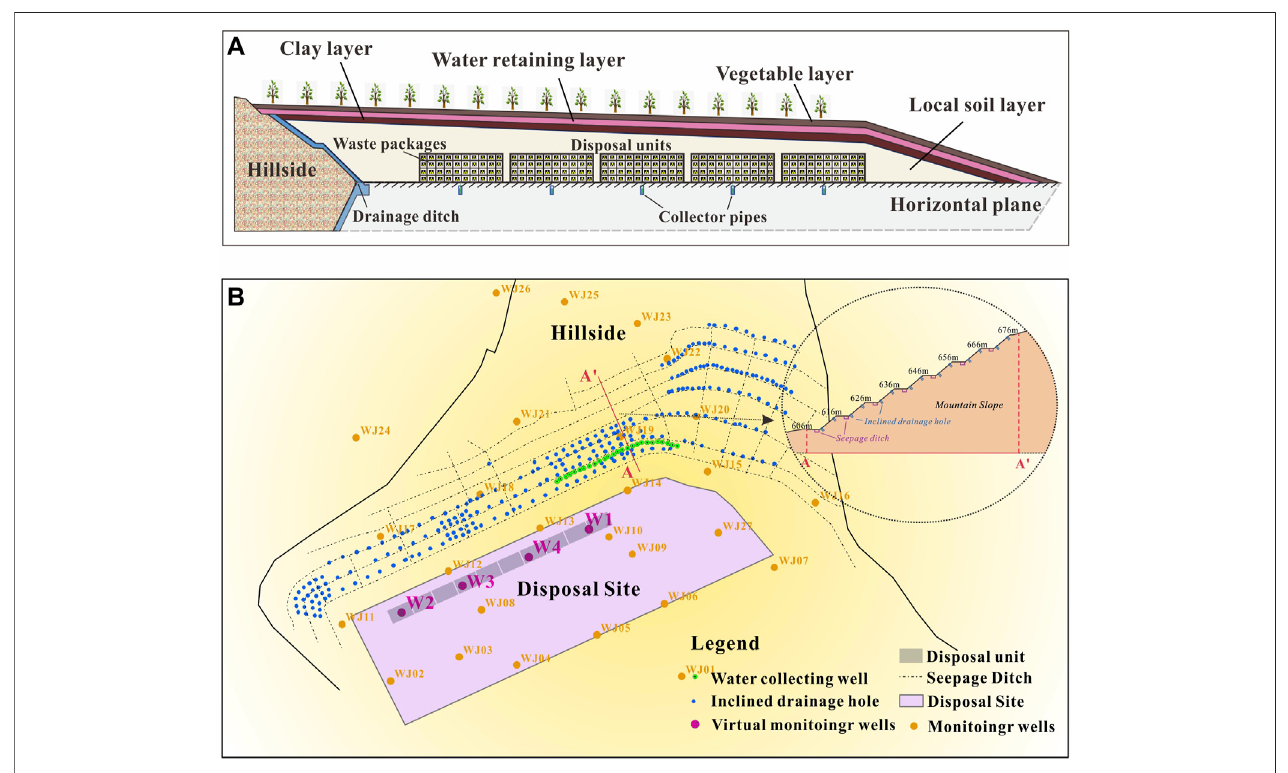
FIGURE 2 | (A) The disposal units ’ generalized structure of the LILW repository. (B) . Schematic diagram of arti fi cial drainage facilities.